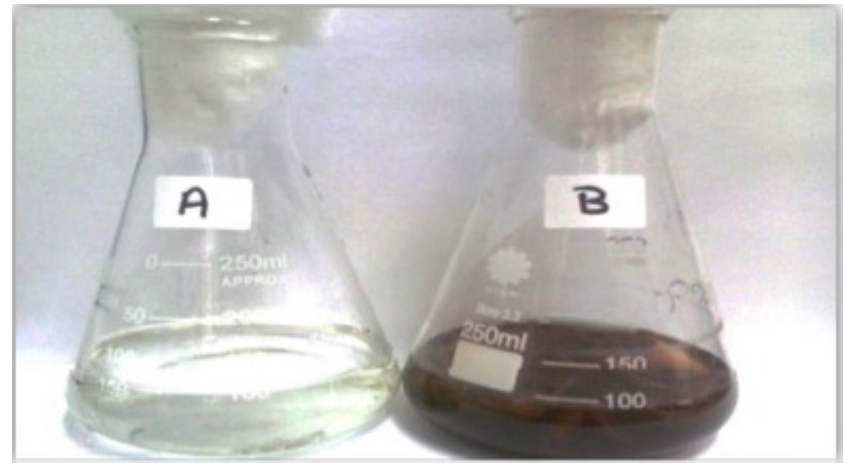
Figure 1. Progress of the biosynthesis process of Ag nanoparticles by Fusarium oxysporum filtrate: ( A ) at zero time after addition of 10 − 3 M AgNO 3 and ( B ) after 72